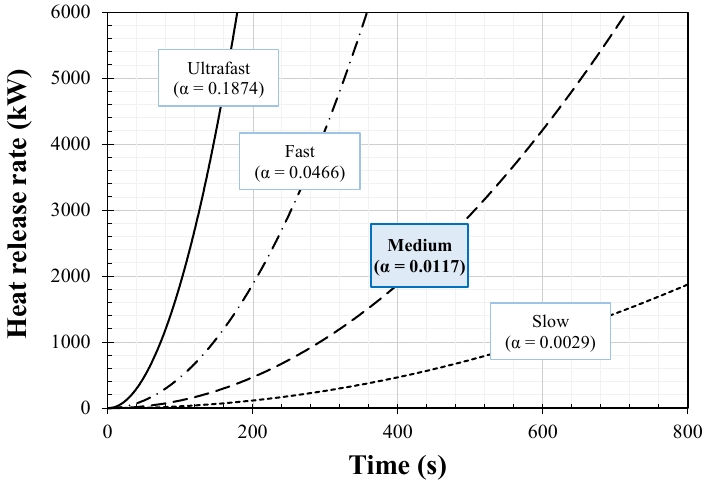
Figure 5. T-square fire curves.